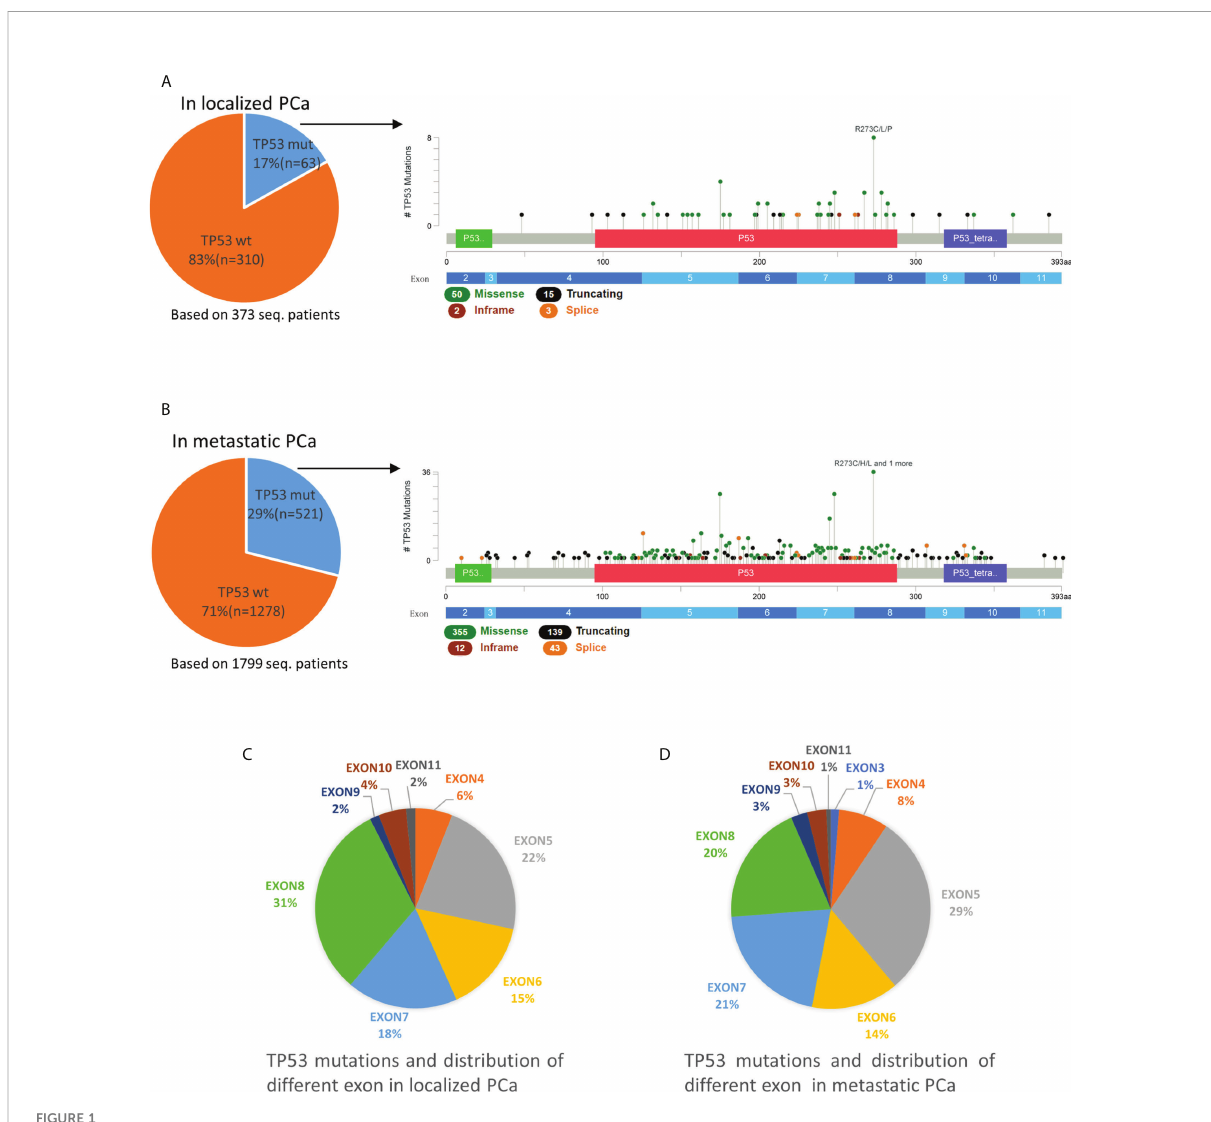
FIGURE 1 Mutation mapping for TP53 in localized PCa (A) and metastatic PCa (B) . Distribution of different TP53 mutation site in localized PCa (C) and metastatic PCa (D) . aa, amino acid; seq., sequencing; TP53wt, TP53 wild type; TP53mut, TP53